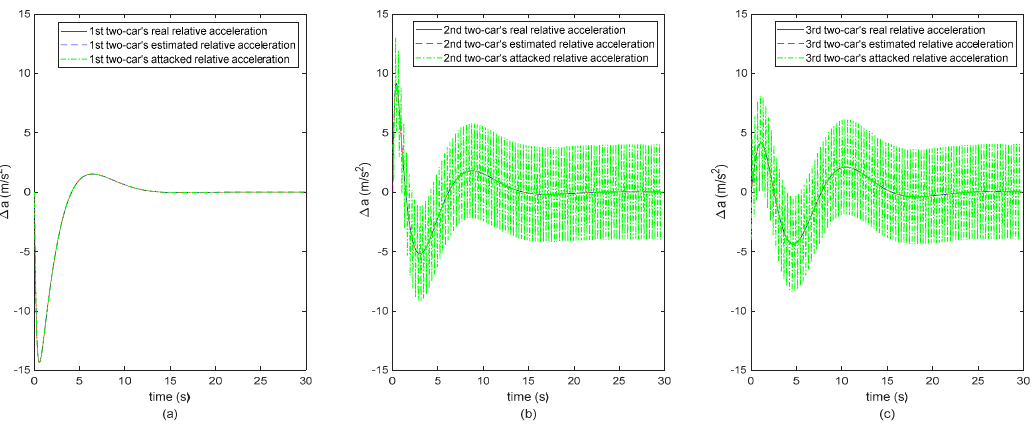
Figure 5. The three 2 ‐ cars’ relative acceleration. ( a ) The 1st two ‐ car, ( b ) The 2nd two ‐ car, ( c ) The 3rd two ‐ car.